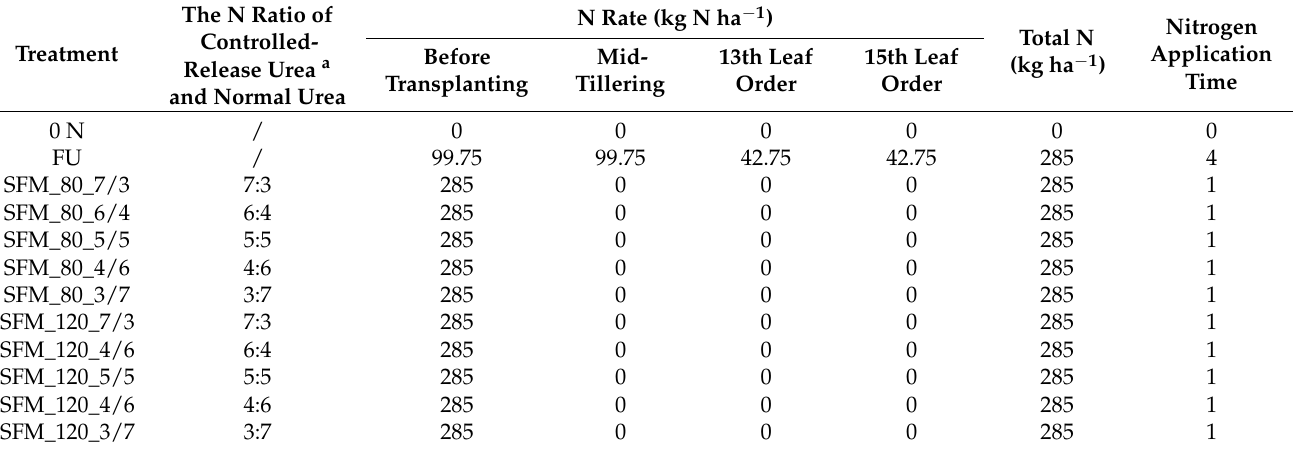
Table 2. Details of nitrogen application